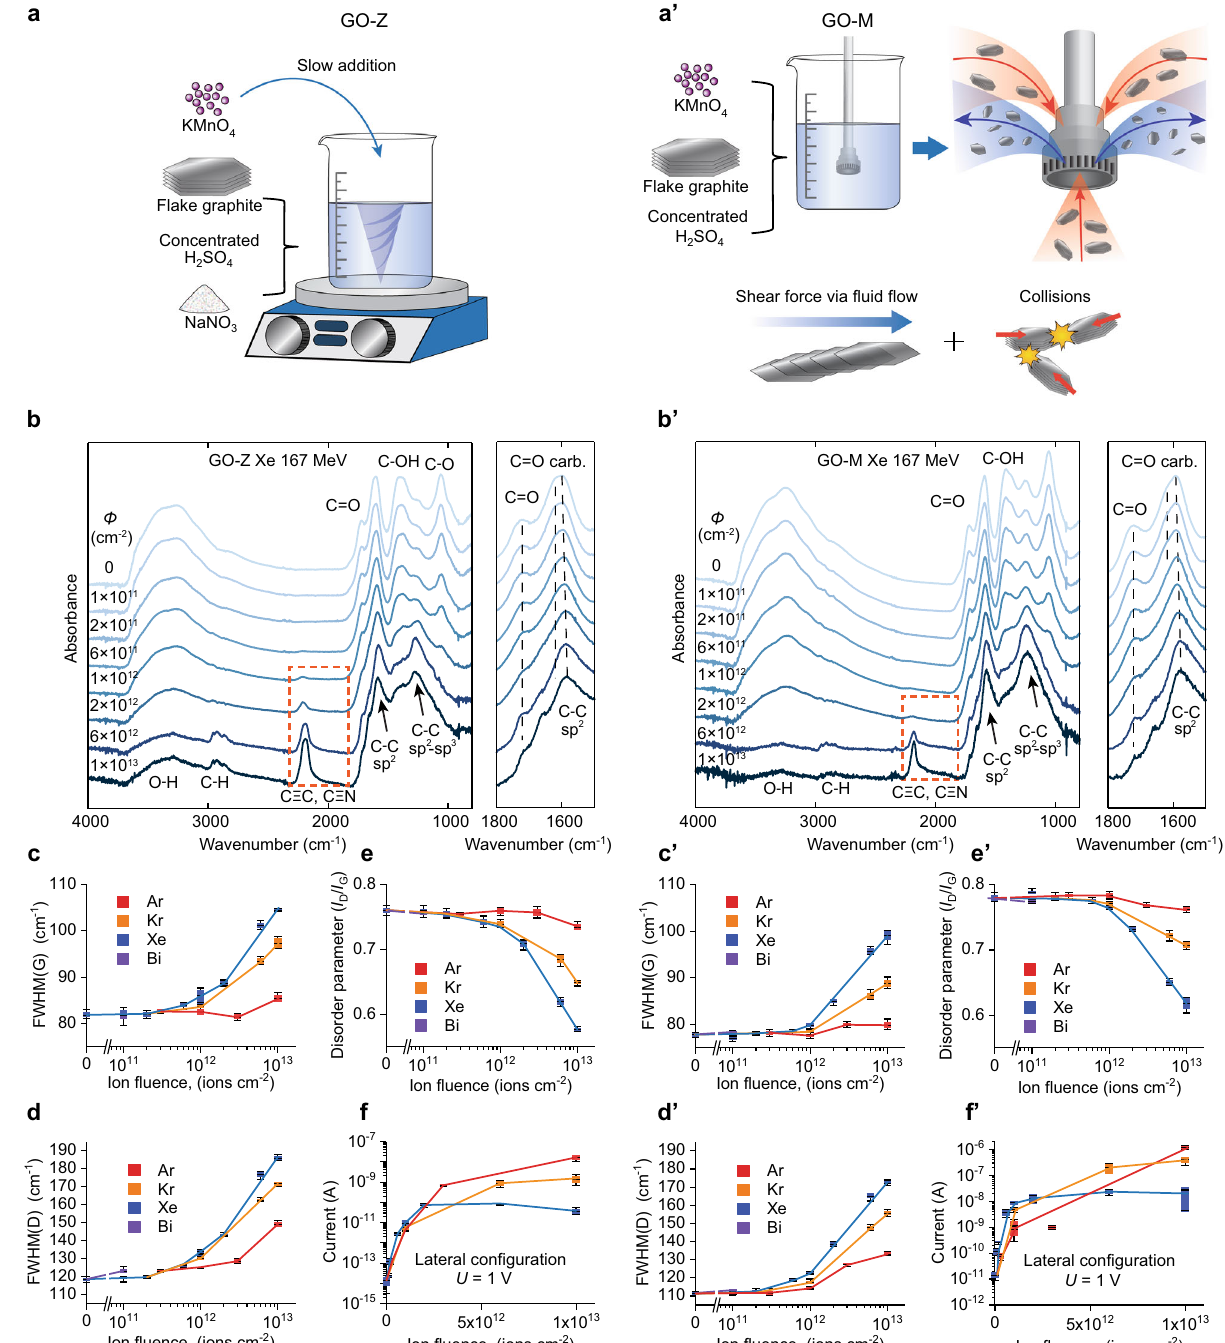
Fig.4|In fl uenceofthechemicalcompositionofGOonSHI-irradiation-induced damage and defunctionalization. Left column GO-Z fi lms obtained by a con- ventional procedure with Hummers reagents; right column GO-M fi lms obtained under conditions facilitating graphene exfoliation and without the use of NaNO 3 . a , a ’ Schematics of GO-Z and GO-M preparation. b , b ’ FT-IR spectra of specimens irradiated with different fl uences of 167MeV Xe ions. The orange boxes mark the spectral region of conjugated C ≡ C bond stretching. c , c ’ – e , e ’ Fluence-dependent